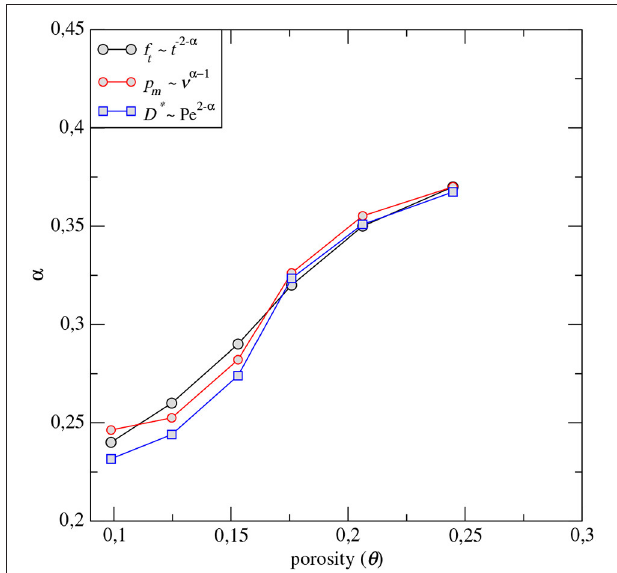
FIGURE 9 | Comparison of the value of α for the FS samples evaluated from (1) the slope of the first passage time plotted in the left panel, (2) the slope of the mean speed PDF plotted in Figure 6 and (3) the slope of the D ∗ / d m vs. Pe plotted in Figure 11 .